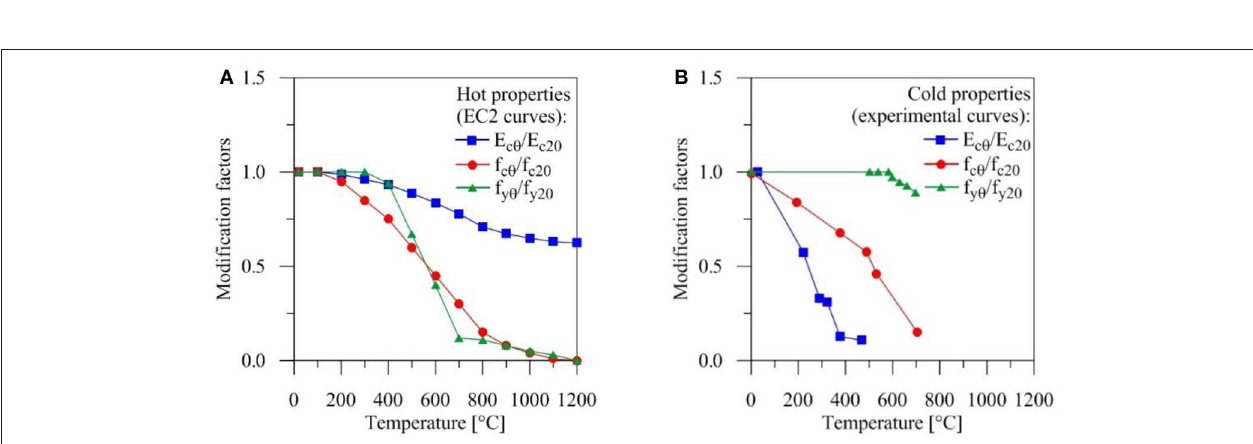
FIGURE 7 | Modification factors of mechanical properties for r.c. frame members during heating and cooling phase: hot (A) and cold (B)